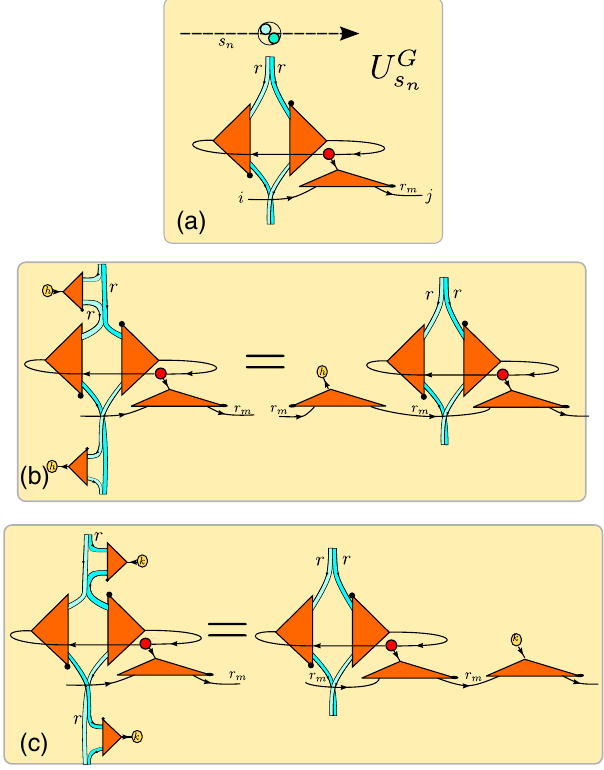
FIG. 18. (a) The U G operatorinthegaugemagnetLGTdefinedin s n Eq. (37). It can be defined, once more, as the contraction of three Γ g Þ ’ s and a copy tensor in C ð G Þ (red circle). (b),(c) From the r ð definition, one can check that it allows us to pass the L and R rotations on the physical legs, induced by the gauge transformation of Fig. 17, to analogous rotations onto the auxiliary legs. The covariance of U G allows us to build a gauge-invariant plaquette s n operator, defined as in Eq. (22), where the rotation on the auxiliary legs cancels by taking the trace onto the auxiliary